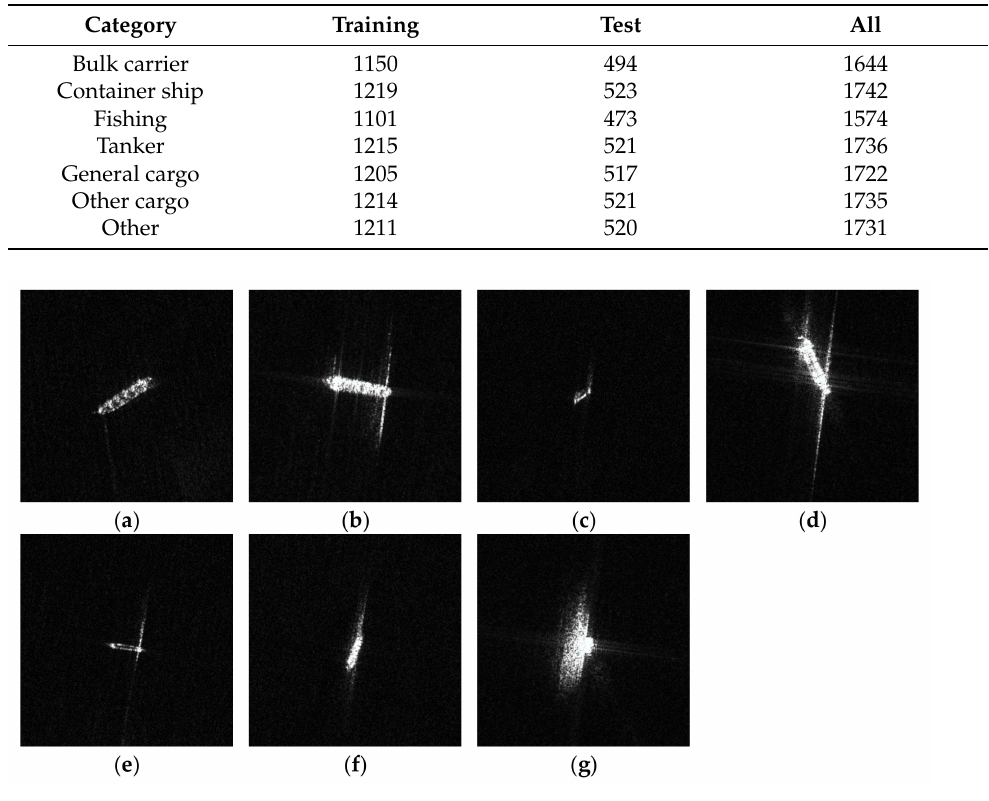
Figure 21. Seven-category SAR ship images in the FUSAR-Ship dataset. ( a ) Bulk carrier; ( b ) container ship; ( c ) fishing; ( d ) tanker; ( e ) general cargo; ( f ) other cargo; ( g )